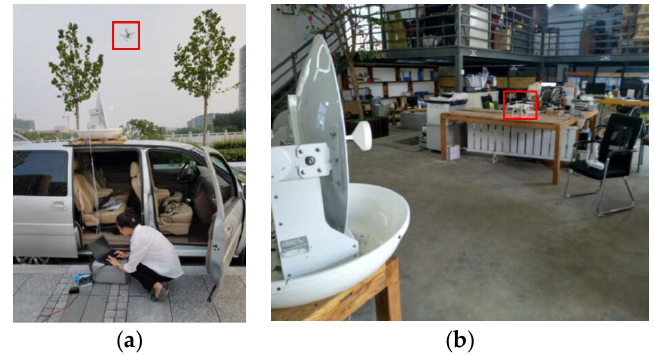
Figure 2. The test environments ( a ) outdoors and ( b ) indoors.